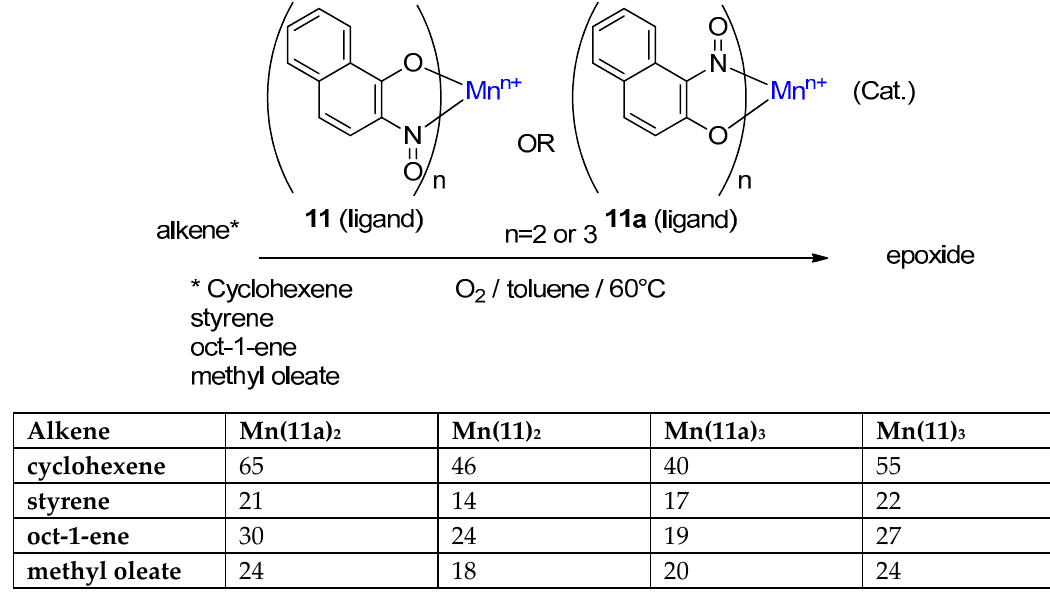
Figure 10. General epoxidation procedure and alkenes tested, with isolated yields given in the table for all four substrates and four catalysts [30].